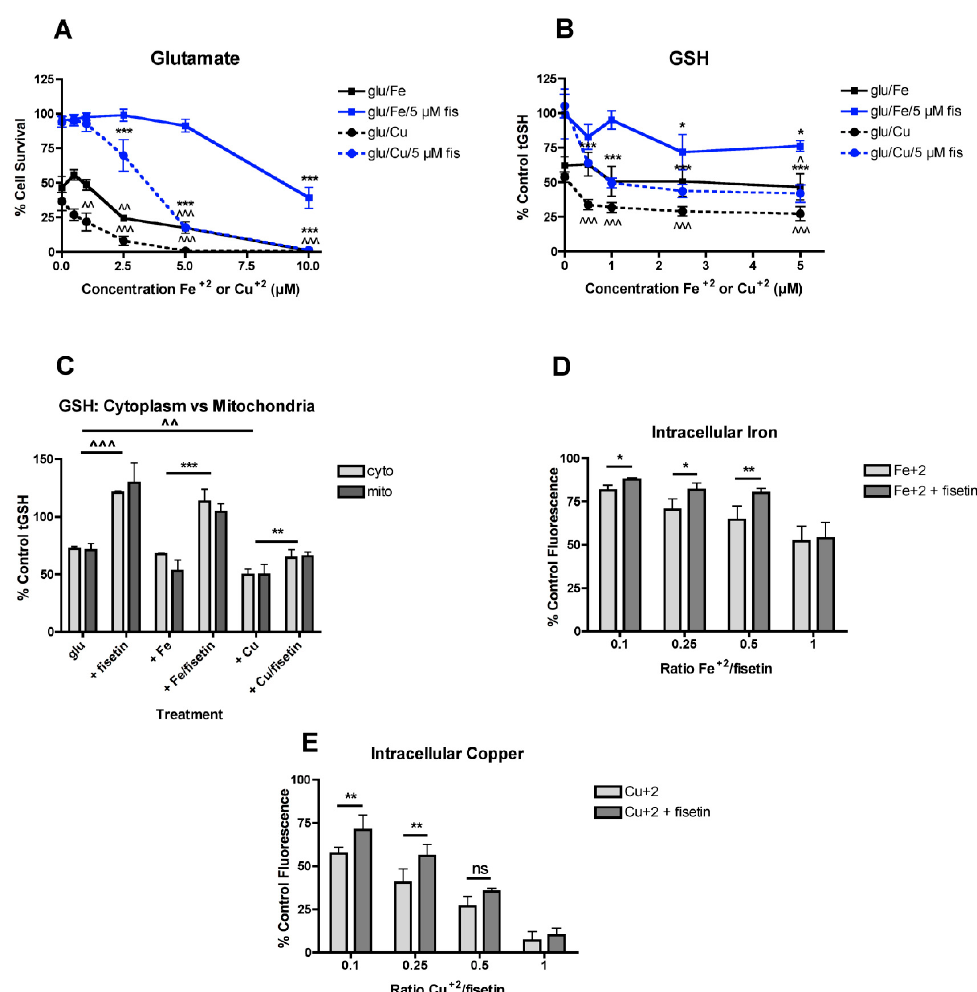
Figure 1. FeCl 2 and CuCl 2 modulate the e ff ects of fisetin on survival and GSH. ( A ) Fisetin reduces the potentiation of glutamate toxicity by FeCl 2 and CuCl 2 . HT22 cells were treated with 2.5 mM glutamate in the presence of 5 µ M fisetin and / or FeCl 2 or CuCl 2 at the indicated concentrations. Cell survival was measured after 24 h with the MTT assay. The experiments were done in quadruplicate and the results are the average of 5–6 independent experiments. ( B ) Fisetin reduces the potentiation of total GSH loss by FeCl 2 and CuCl 2 . HT22 cells were treated with 2.5 mM glutamate in the presence of 5 µ M fisetin and / or FeCl 2 or CuCl 2 at the indicated concentrations. Cells were harvested after 24 h and total GSH was measured. The results are the average of 5-6 independent experiments. * indicates p < 0.05 and *** indicates p < 0.001 relative to fisetin + glutamate alone and ˆ indicates p < 0.05, ˆˆ indicates p < 0.01 and ˆˆˆ indicates p < 0.001 relative to glutamate alone. ( C ) Fisetin similarly reduces the potentiation of total GSH loss by FeCl 2 and CuCl 2 in both cytoplasm and mitochondria. HT22 cells were treated with 2.5 mM glutamate in the presence of 10 µ M fisetin and / or 5 µ M FeCl 2 or CuCl 2 (0.5:1, metal:fisetin). Cells were harvested after 24 h, separated into cytoplasmic and mitochondrial fractions and total GSH was measured. The results are the average of 4–6 independent experiments. ** indicates p < 0.01 and *** indicates p < 0.001 relative to fisetin + glutamate alone. ˆˆ indicates p < 0.01 and ˆˆˆ indicates p < 0.001 relative to glutamate alone. ( D ) Fisetin reduces free intracellular Fe 2 + levels at Fe 2 + :fisetin ratios of 0.5:1 and below. Free intracellular Fe 2 + was measured using the dye PhenGreen SK after 3 h of treatment with 10 µ M fisetin and the indicated concentrations of FeCl 2 . ( E ) Fisetin reduces free intracellular Cu 2 + levels at Cu 2 + :fisetin ratios of 0.25:1 and below. Free intracellular Cu 2 + was measured using the dye PhenGreen FL after 3 h of treatment with 10 µ M fisetin and the indicated concentrations of CuCl 2 . The experiments were done in sextuplicate and the results are the average of 4–6 independent experiments. * indicates p < 0.05 and ** indicates p < 0.01 relative to the metal